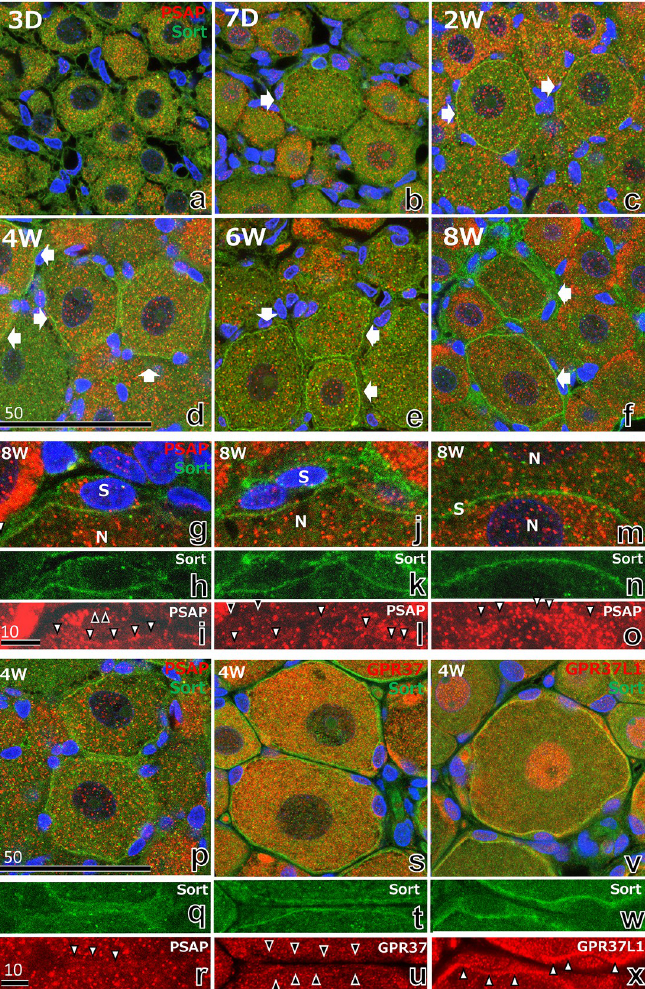
Fig 10. (a–f) Immunofluorescence light micrographs of the rat DRG from 3 days to 8 weeks after birth, stained with anti-PSAP (red), anti-sortilin (Solt, green), and DAPI. Weak sortilin-IR was first observed at postnatal day 7 in satellite cells (arrows in b). After postnatal week 2, the number of sortilin-positive cells increased, peaking at postnatal week 4 (arrows in d) and decreasing after postnatal week 8 (f). (g–o) Higher magnification immunofluorescence light micrographs of the rat DRG at 8 weeks after birth stained with antibodies against PSAP (red), sortilin (green), and DAPI (blue). (g, j) Both the outer and inner cell surface of satellite cells were clearly outlined by sortilin, while only the inner surface of satellite cells was outlined with fine granular PSAP (white arrowheads in i, l, and o), and not the outer cell surface (black arrowheads in i, l). (m) Rare case of a thin satellite cell (S) between two neurons (N), indicating clear colocalization of sortilin (n) and PSAP (o). (p–x) The relationships of PSAP and its receptors (GPR37, GPR37L1) with sortilin was studied by double immunofluorescence of the DRG at postnatal week 4. Sortilin-IR was localized in satellite cells, especially near the boundary to nerve cells (q, t, and w), while PSAP-IR (r) and GPR37-IR (u) were dispersed in the cytoplasm of satellite cells. Only GPR37L1 clearly colocalized with sortilin (w, x). The numbers on the bars indicate the scale in μ